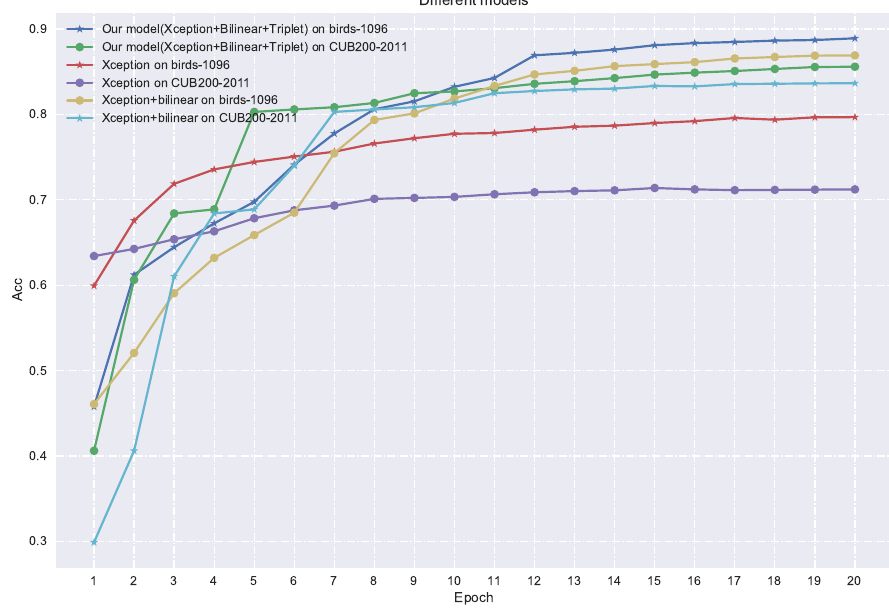
Figure 10. Acc curves of the evaluated different models trained on Birds-1096 and CUB200-2011. Table 2. Accuracy comparisons of our model and other models. CNN: convolutional neural network. Model Dataset Acc Our model (Xception+Bilinear+Triplet) Birds-1096